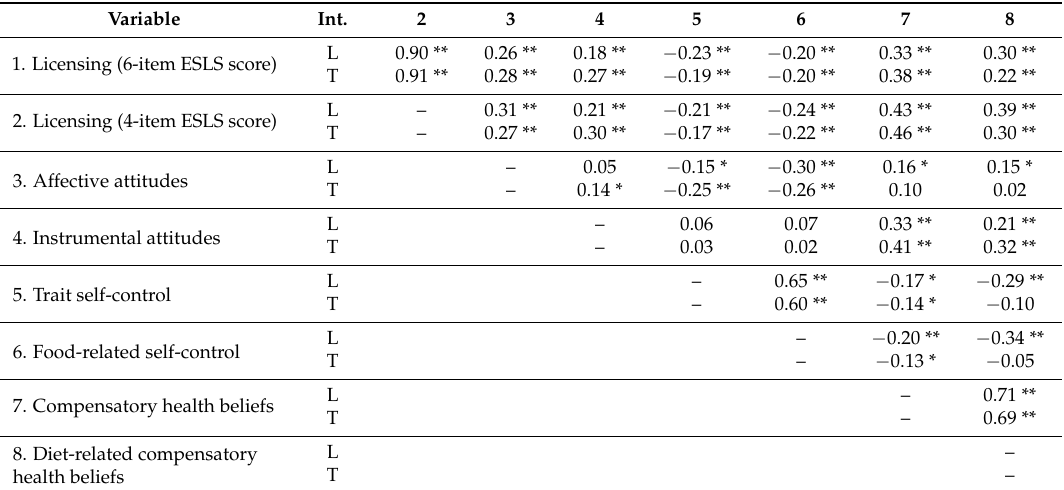
Table 5. Correlations with diet-related and dispositional correlates for four- and six-item versions of “light” ( n = 211) and “tiring” ( n = 313) ESLS. Variable